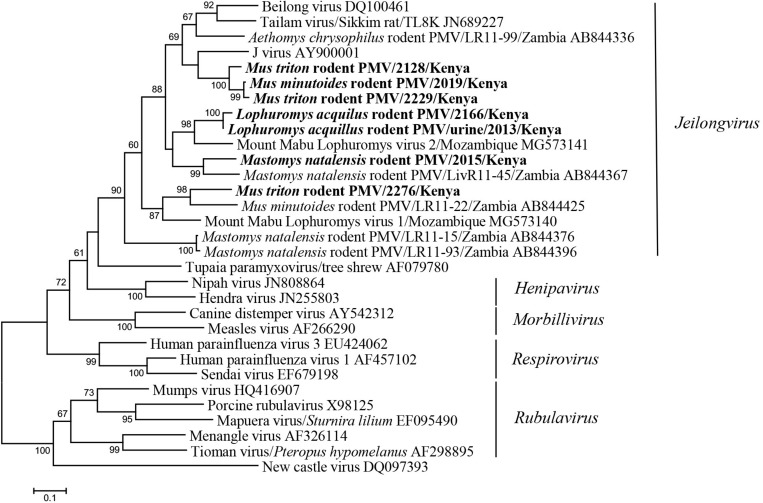
ML tree based on 506-nt partial L gene of paramyxoviruses (corresponding to Beilong virus genome nt 14889-15394, DQ100461). Strains detected in this study are indicated in bold.